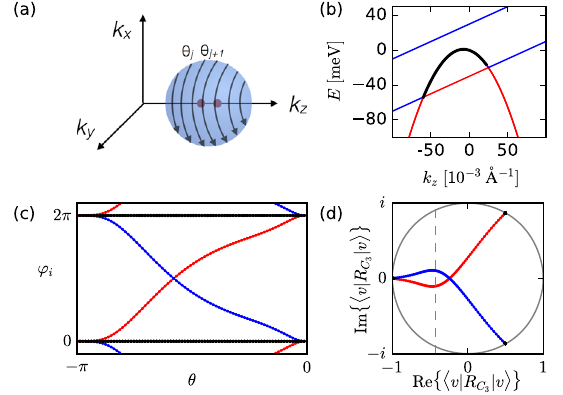
13. (a) Pair of TPs (red points) connected by a nodal line (red line) enclosed by a sphere. The arrows indicate the individual Wilson loops winding around the sphere. (b) Example of a trivial pair of TPs. (c) The Wilson loop spectrum on a sphere enclosing a pair of TPs. Two Wilson loop eigenvalues feature gapless flow (red and blue). (d) C 3 -symmetry expectation value of individual Wilson